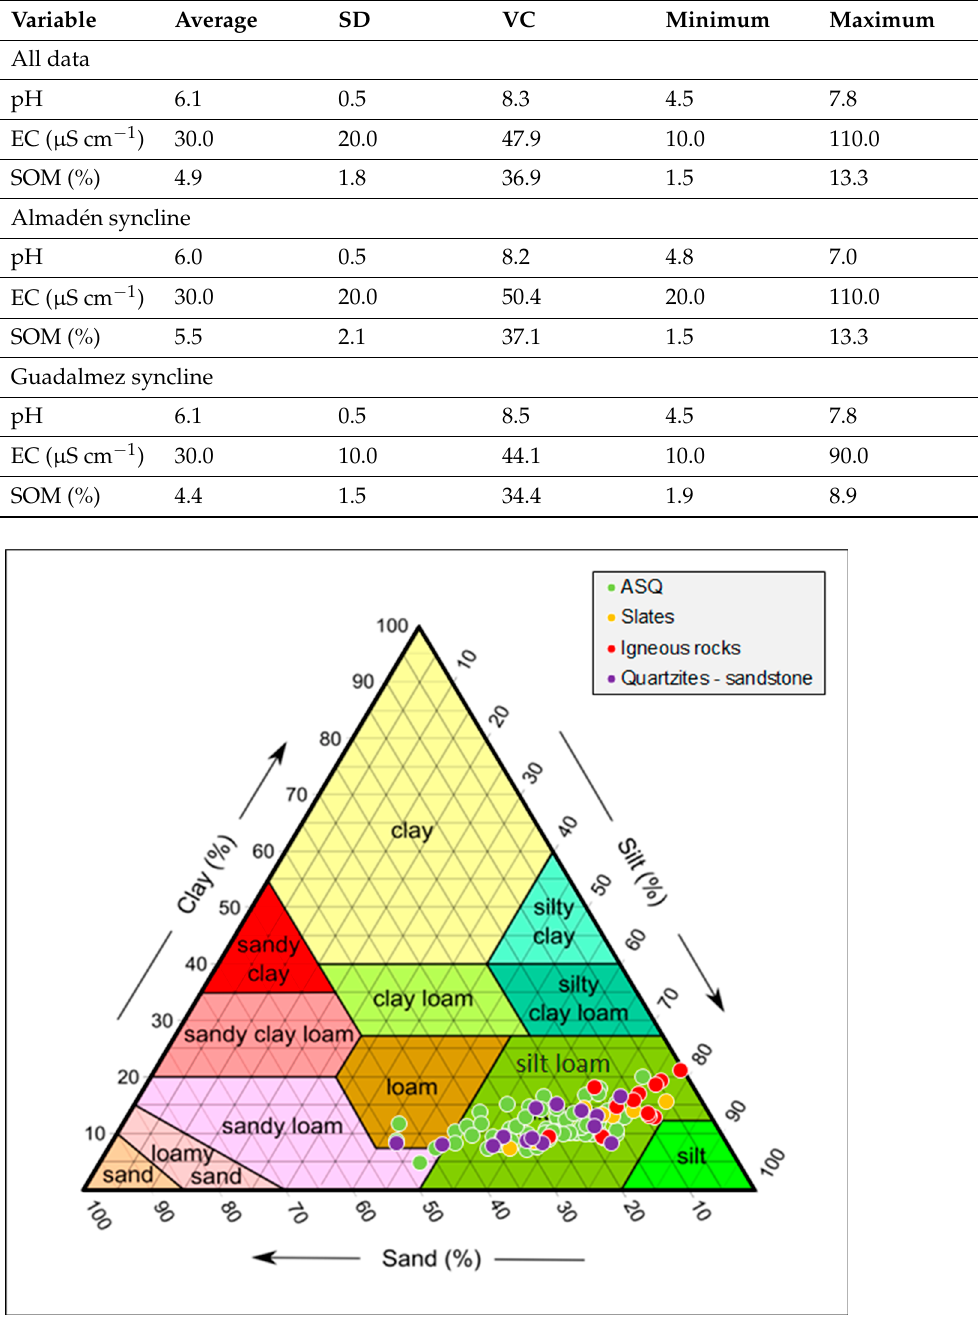
Table 1. Statistical summary of pedological parameters. Abbreviations: SD: standard deviation; SOM: soil organic matter; VC: variation coefficient. Complete data available in Table S1.